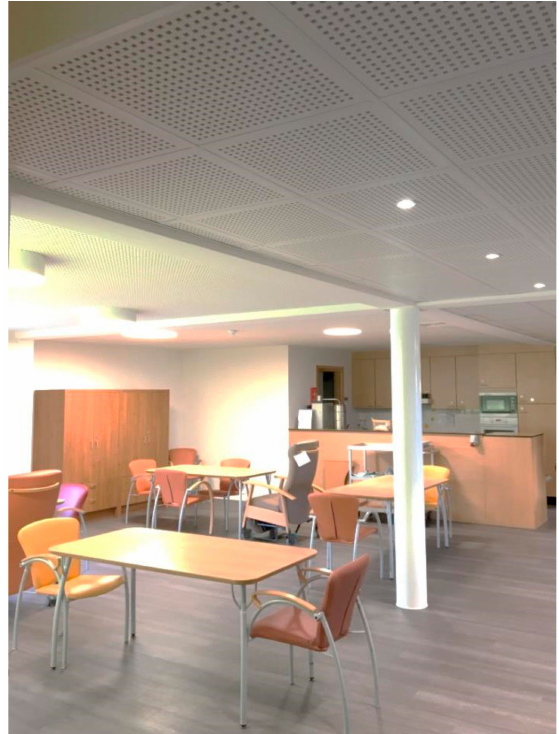
Figure 5. Picture of the nursing home (NH) living room after the installation of the acoustic floating floor and absorbing